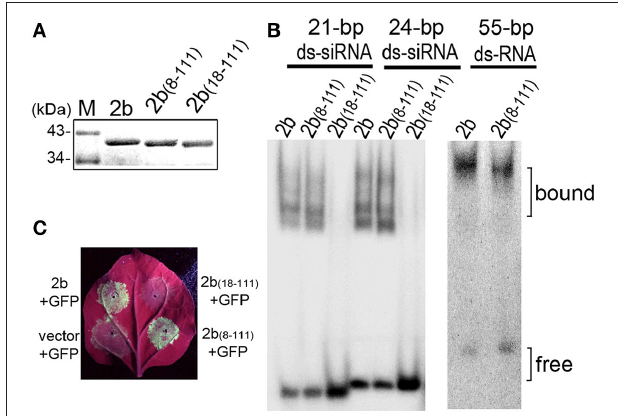
FIGURE 2 | Detection of the suppression of the transgene-induced silencing and dsRNA-binding activity of 2b and its mutations. (A) Purified GST-tagged 2b, 2b (8 – 111) , and 2b (18 – 111) . (B) Gel mobility shift assays for the detection of the dsRNA binding affinity. GST-tagged 2b, 2b (8 – 111) , and 2b (18 – 111) were incubated with siRNA duplexes and long dsRNA. 2b (8 – 111) showed a high affinity for 21/24-nt siRNA duplexes, similar to 2b, but showed a reduced affinity for long dsRNA; 2b (18 – 111) showed no binding to 21/24-nt siRNA duplexes. (C) GFP fluorescence in the leaves of Nb plants coinfiltrated with GFP and 2b or mutants. Coinfiltration of GFP with vector was used as control. Photographs were taken under UV light at 4 dpi.